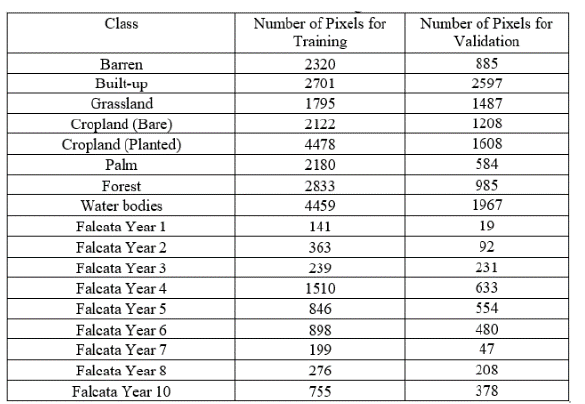
Table 3 . Summary of training and validation data for pixel- based machine learning classification of Falcata stand age.